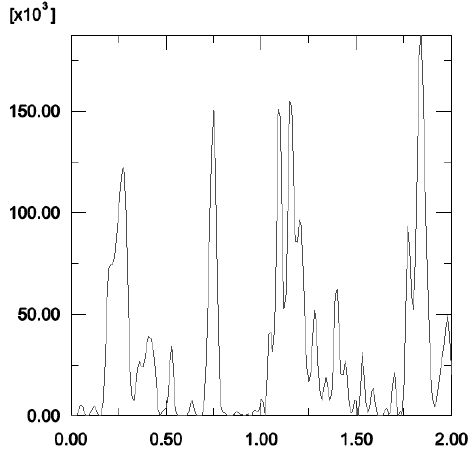
Fig. 9. Second optimization